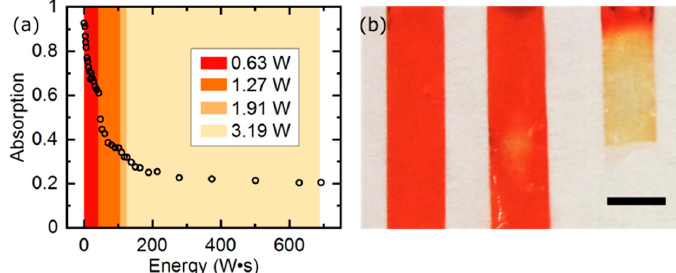
Figure 5. Measured LCE actuator absorption loss vs. the total light energy absorbed. Total absorbed light energy, calculated as the absorbed laser power times the exposure time, is plotted on the horizontal axis. Increasing laser power was used in four consecutive time ranges to speed up the experiment ( a ). Optical photograph of a 10 µm thick LCE film with 1 wt % of DR 1. Before the experiment (0 J total absorbed energy, left) and during the experiment (50 J total absorbed energy, center). Dye degradation is visible as a transparent spot in the center of the laser illuminated area. At the end of the experiment, the entire irradiated area became transparent and the actuator was broken (above 700 J total absorbed energy, right) ( b ). The black scale bar is 2 mm long.